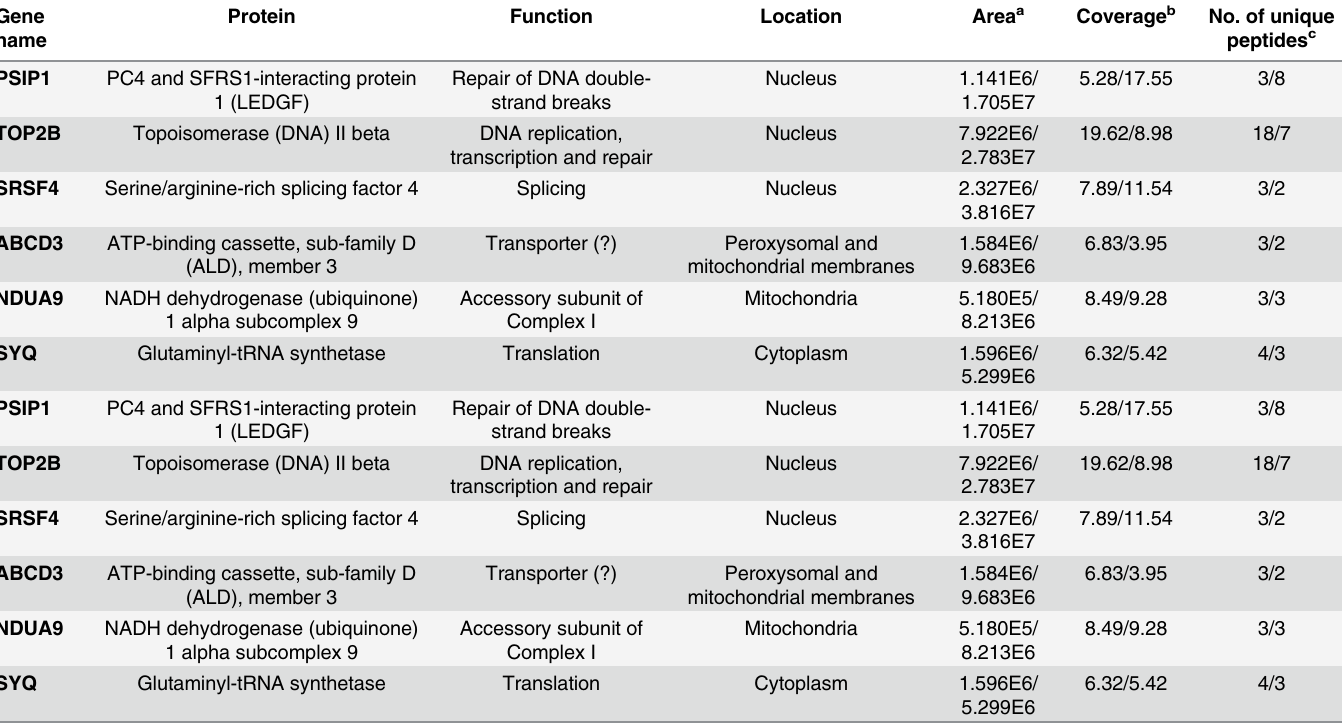
Table 1. List of proteins that selectively interact with unphosphorylatable form of rpS6. Whole cell extract from HEK293 cells infected with pS6 [5S] - GFP, pS6 [5A] -GFP, pS6 [5D] -GFP or pEGFP-N1, was subjected to GFP pull-down, and the bound proteins were size fractionated by SDS-polyacrlamide gel electrophoresis. Mass spectrometric analysis of proteins in each lane was performed as described in “ material and Methods ” and proteins, selectively bound to pS6 [5A] -GFP in two independent experiments, are presented (numbers separated by slash [/] represent results obtained in each of the two individual